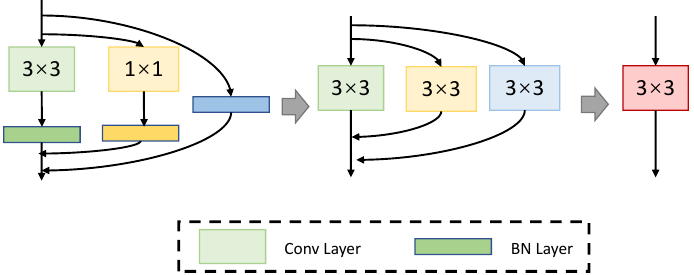
Figure 3. Structural reparameterization of backbone. The model used in training involves 3 channels, conventionally including 3 × 3 convolution, 1 × 1 convolution, and identity, each followed by a batch normalization layer. When the model is used for testing, there is only one channel shown on the